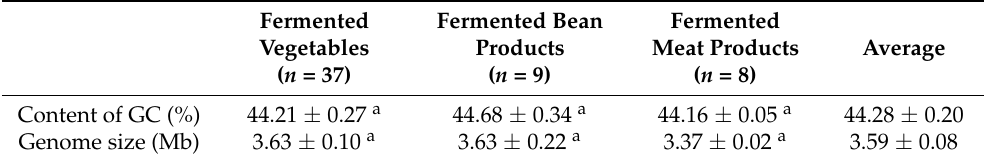
Table 1. Analysis of significant differences in GC content and genome size of Lactobacillus plantarum isolated from different